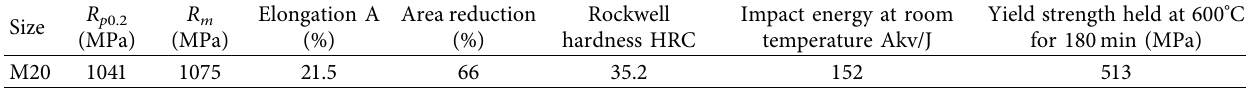
Table 3: Mechanical behavior of the fre-resistant and high-strength grade 10.9 bolt.